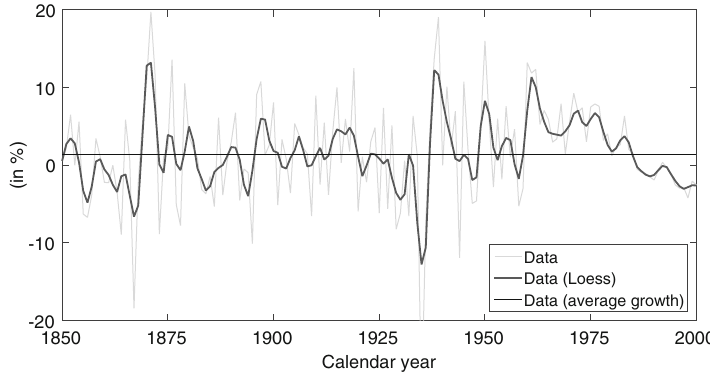
Fig. 6 Labor-augmenting technological progress, Spain 1850–2000. Source Authors’ calculations. Note The ‘Loess’ smoothing profile was computed using a bandwidth of 0.05 and rescaled to give an annual average growth rate of